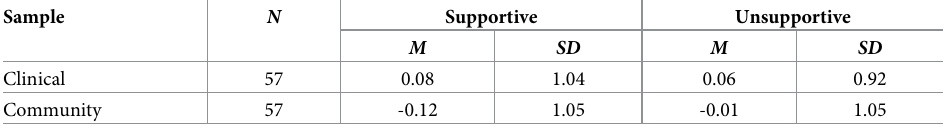
Table 5. Means and standard deviations (z-Standardized) of supportive and unsupportive reactions of parents in the clinical sample and the community sample for the matched sample. Sample